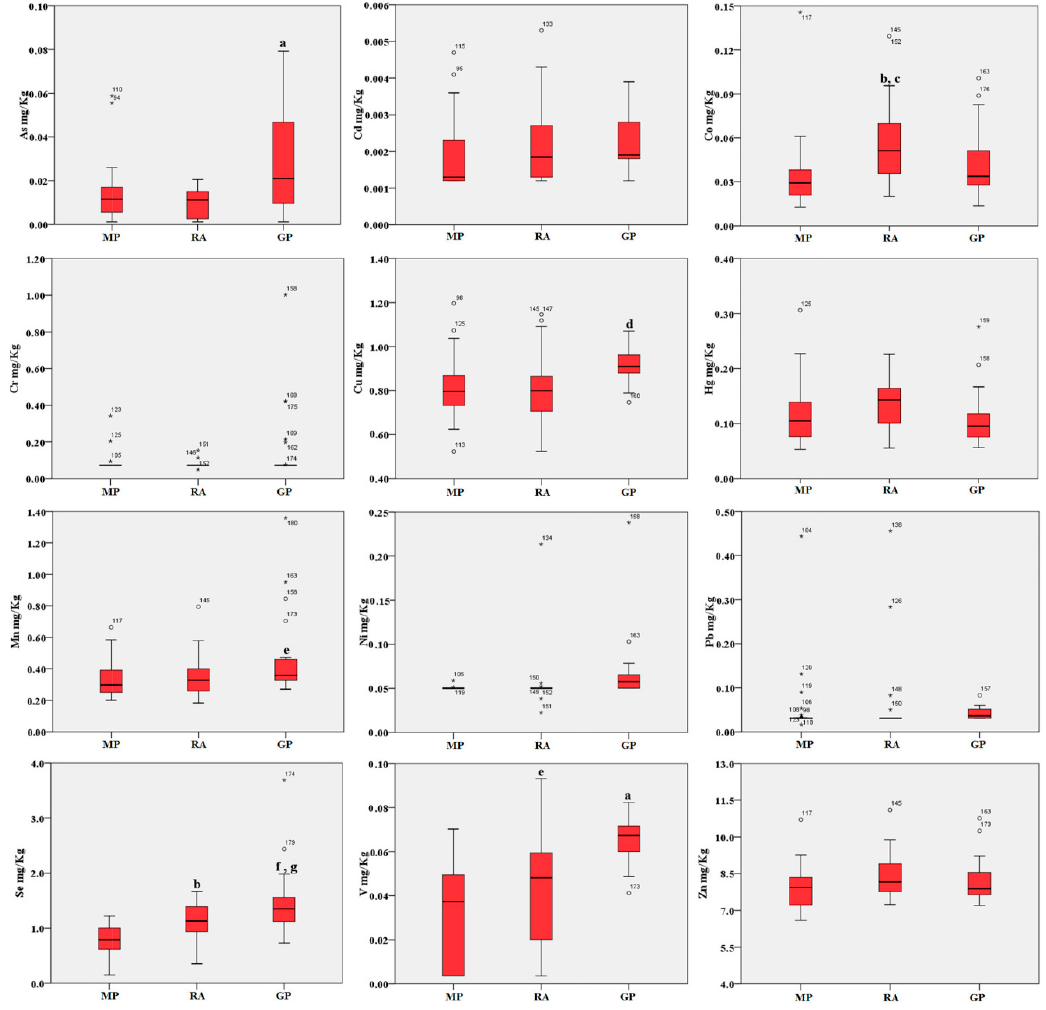
Figure 2. Boxplot of the trace elements in blood (mg / kg d.w.) of birds from the three areas. MP: Magnisi peninsula; RA: Ragusa agro-ecosystem; GP: Gela plain. The box represents the interquartile (IQ) range and contains the 1st quartile, the median and the 3rd quartile; whiskers represent extreme values of minimum and maximum; in addition, outliers with values between 1.5 and 3 times the IQ range are displayed. Legend: a = p < 0.001 vs. MP and RA; b = p < 0.01 vs. MP; c = p < 0.05 vs. GP; d = p < 0.01 vs. MP and RA; e = p < 0.05 vs. MP; f = p < 0.001 vs. MP; g = p < 0.05 vs. RA.